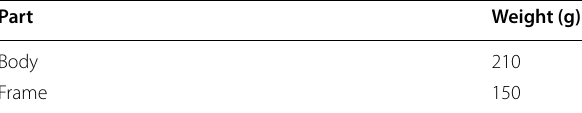
Table 1 Weight of the proposed exoskeleton